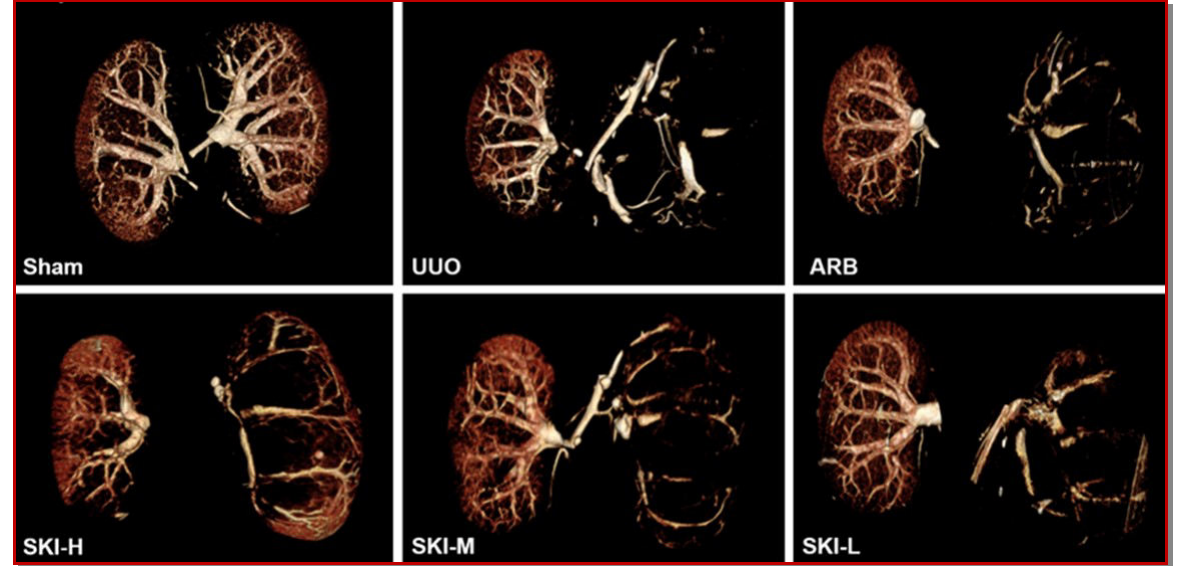
Figure 2: Effects of shenkang injection on renal vasculature. SKI-H means shenkang injection (7.8 g/kg); SKI-M means shenkang injection (3.9 g/kg); SKI-L means shenkang injection (1.95 g/kg); Renal vasculature was observed by micro-CT with a Siemens micro-CT scanner. 3D images were reconstructed by Siemens Inveon Research Workplace software